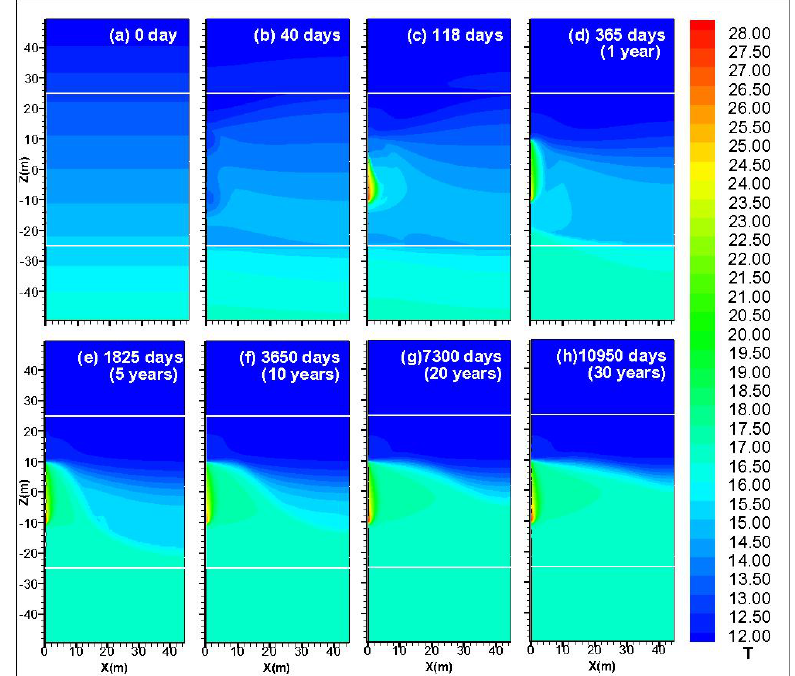
Figure 10. Evolution of the spatial distribution of T during hydrate dissociation (the Reference